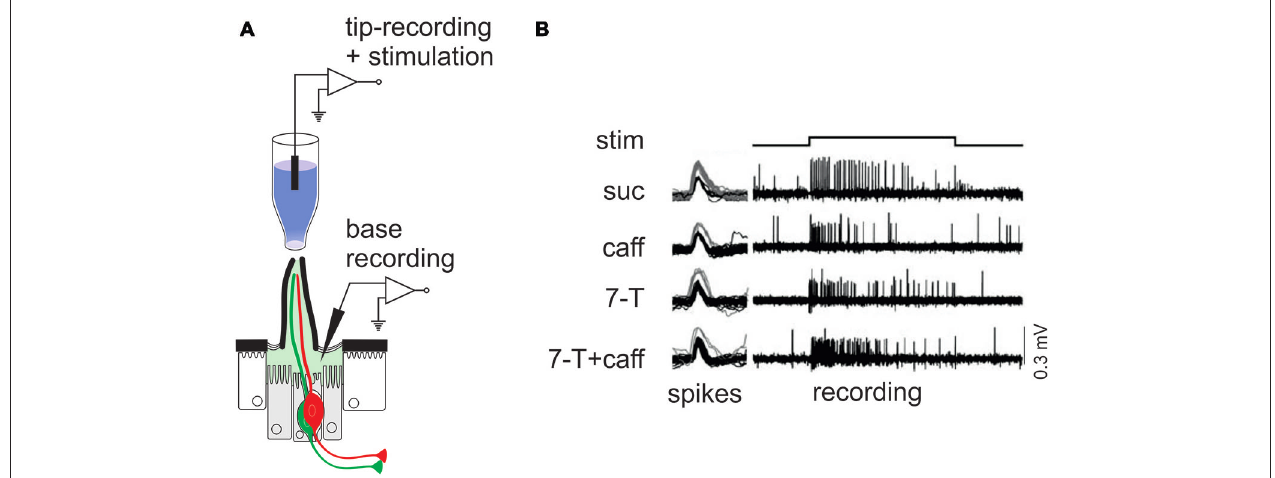
FIGURE 3 | Bitter-sensitive cells respond also to inhibitory sexual pheromones. (A) Diagram showing the two electrodes configuration used to record extracellular activities from taste sensilla of Drosophila . In all cases, a glass capillary containing the stimulus is used to cap the tip of a gustatory sensillum. If the stimulus is water-soluble, the stimulus electrode can contain an electrolyte and can be used to record electrical signals from the neurons within the sensilla. If the stimulus is lipophilic, the stimulus electrode which contains paraffin oil with the ligand, is no longer conductive and we use another electrode, for example a fine tapered tungsten rod, inserted at the base of a sensillum. (B) Sample recordings obtained from an I-type sensillum on the proboscis of Drosophila using a tungsten recording electrode, and stimulating either with sucrose (suc), caffeine (caff), 7-tricosene (7-T) or a mixture of 7-tricosene and caffeine (reproduced from Lacaille et al.,